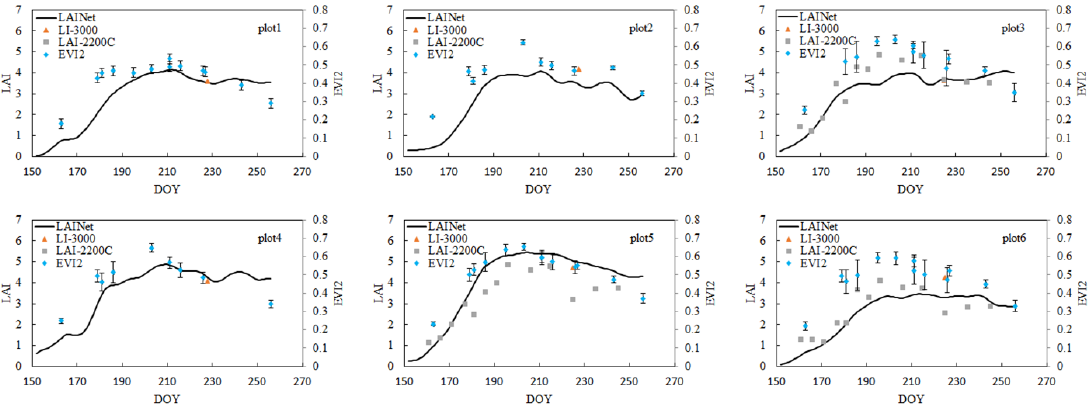
Figure 6. Relationship between field LAI measurements and EVI2 for 2018 (a) and 2019 (b). The color bar indicates observation dates (i.e., DOY, day of year).